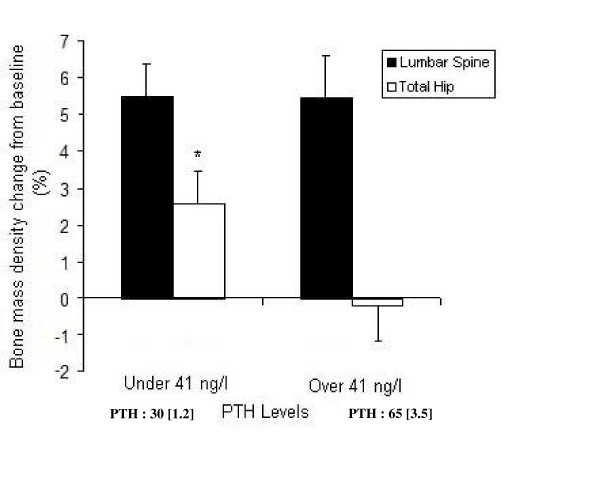
Percentage change in BMD from baseline during bisphosphonate treatment at the lumbar spine and total hip in the study population divided into 2 groups based on their serum PTH concentration (cut-off value: 41 ng/L). A significant difference in % change in BMD at the hip was observed between the 2 groups. Values are shown as the mean [SEM], * p < 0.05.